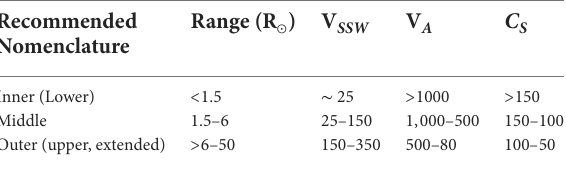
TABLE 1 Levels of the Solar Corona, with heliocentric ranges and representative speeds (km/s); slow solar wind (SSW), Alfvén wave (A), acoustic waves